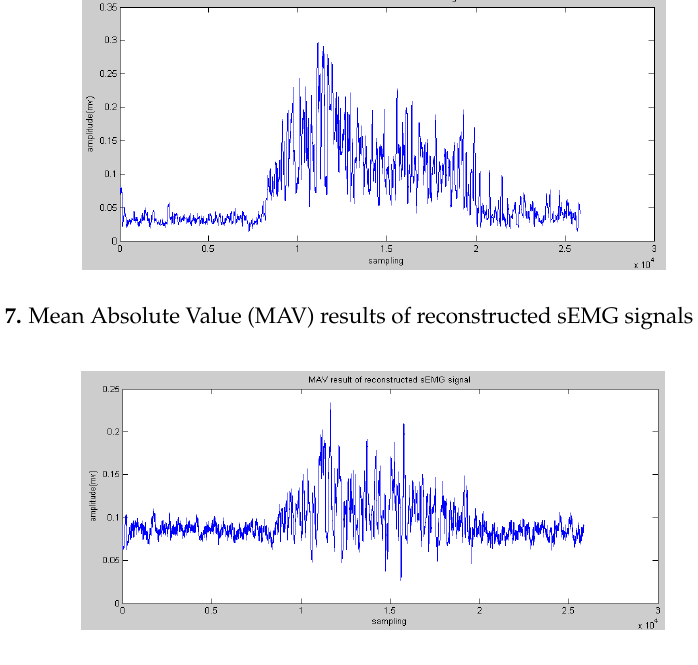
Figure 8. MAV results of reconstructed sEMG signals in node 4.1.